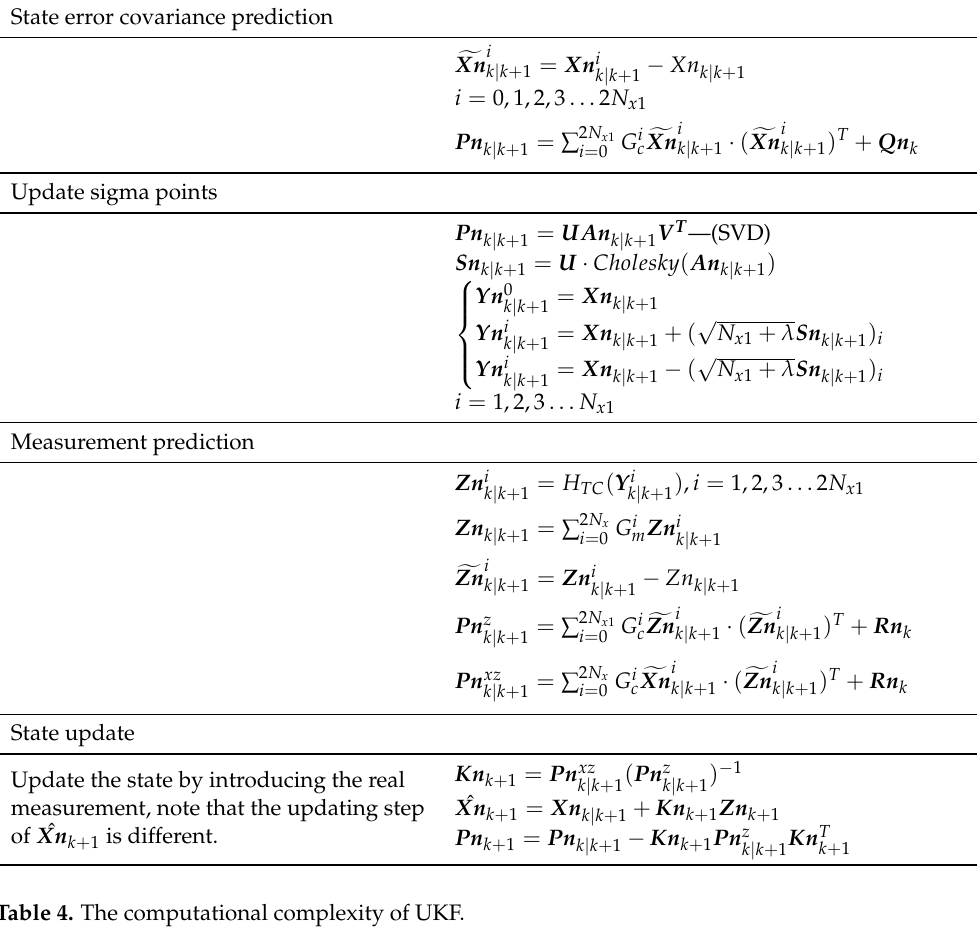
Table 3. Cont. State error covariance prediction